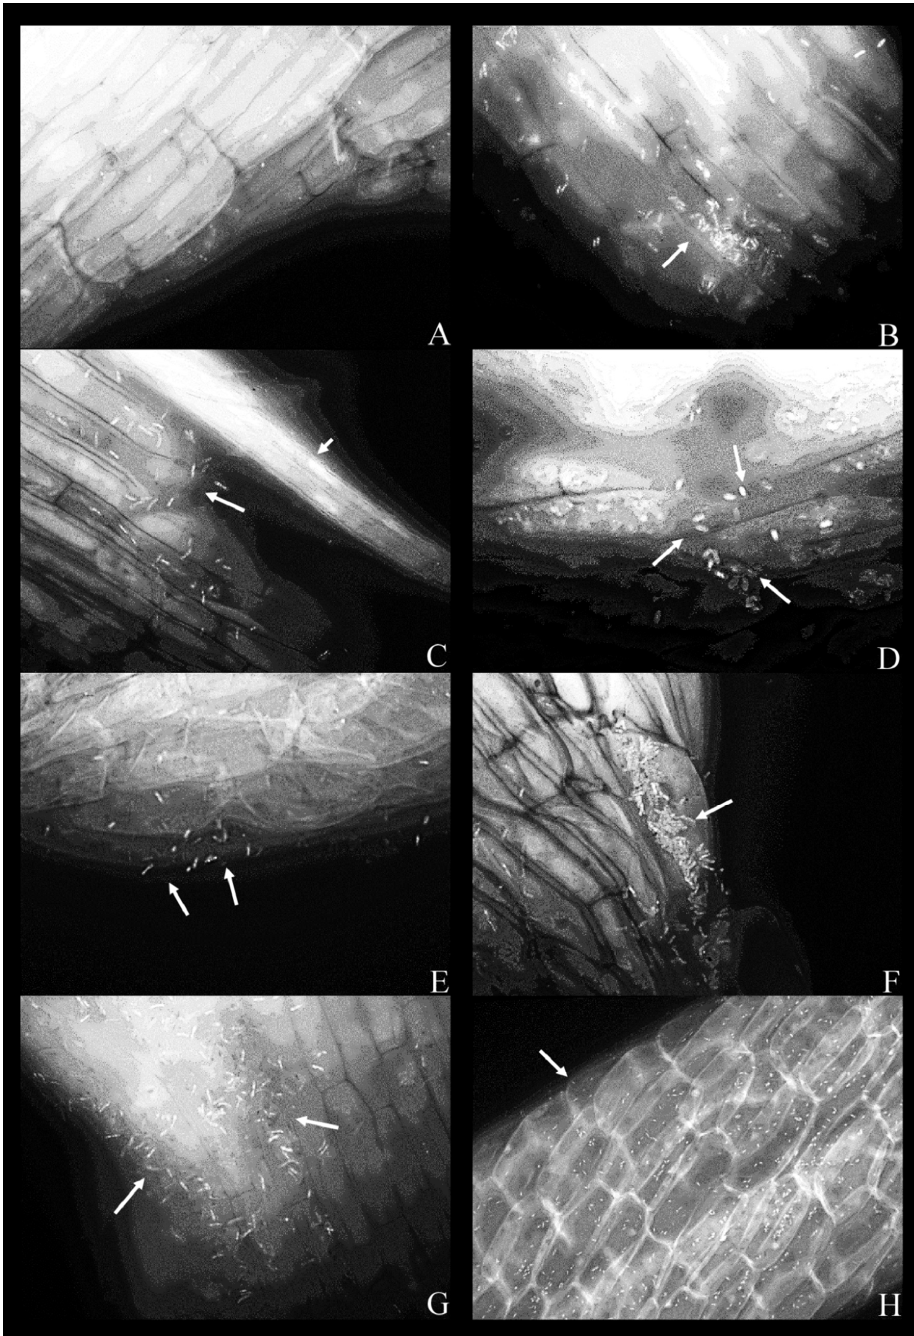
Figure 2. Fluorescent micrographs of duckweed roots in phenol-free MS medium with bacterial strains: ( A ) 9— Klebsiella oxytoca ; ( B ) 11— Lelliottia sp., a bacterial microcolony on the root surface (arrow); ( C ) 14— K. oxytoca , bacterial cells on the root surface (arrow) with a vascular bundle (arrowhead); ( D ) 14— K. oxytoca (magnified 100 × ), bacterial cells arranged around a rupture in the root; ( E ) 27— Serratia marcescens , representative bacterial cells on the root surface (arrows); ( F ) 37— H. alvei , bacterial cells organized in a microcolony (arrow); ( G ) 43— H. paralvei , a microcolony; ( H ) 51— S. nematodiphila (magnified 40 × ); bacterial cells are arranged along the lines between the epidermal cells of the root. Magnification: 63 × , unless stated otherwise. Arrows: bacterial cells on the root surface. Arrowhead: a vascular